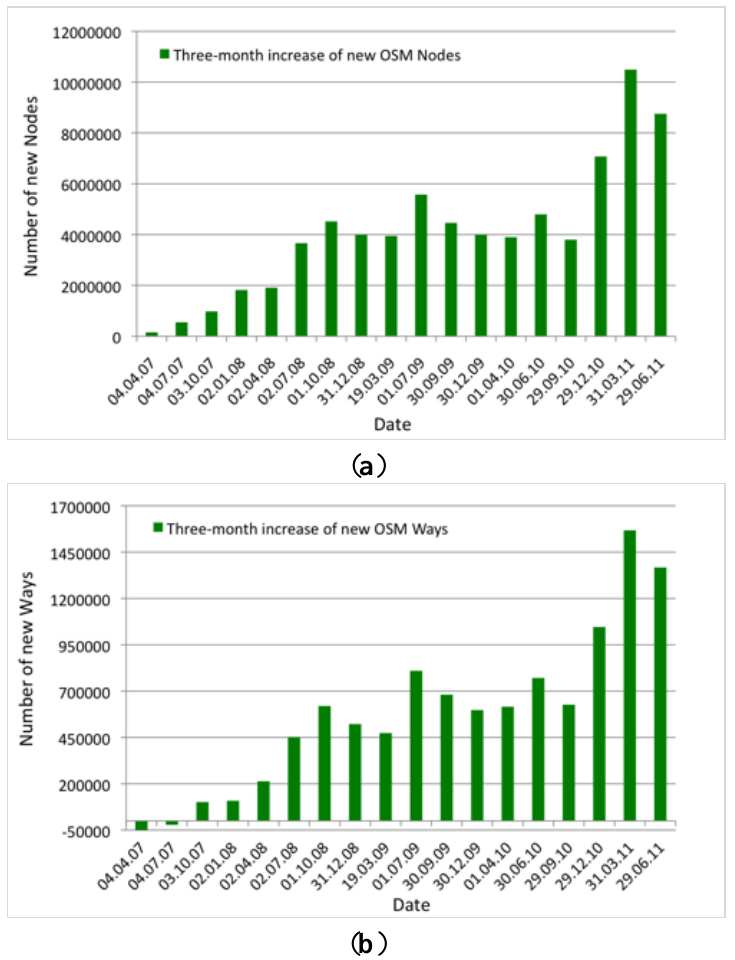
Figure 2. ( a ) Development of OSM Nodes in Germany; ( b ) Development of OSM Ways in